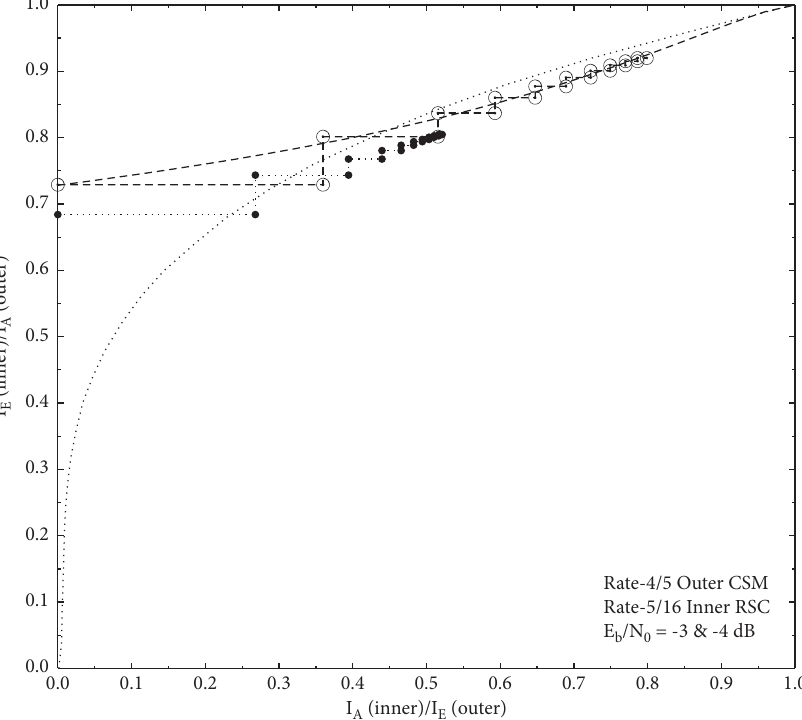
Figure 8: EXIT chart curves and decoding trajectories for Rate-4/5 CSM ( Mapping-I )